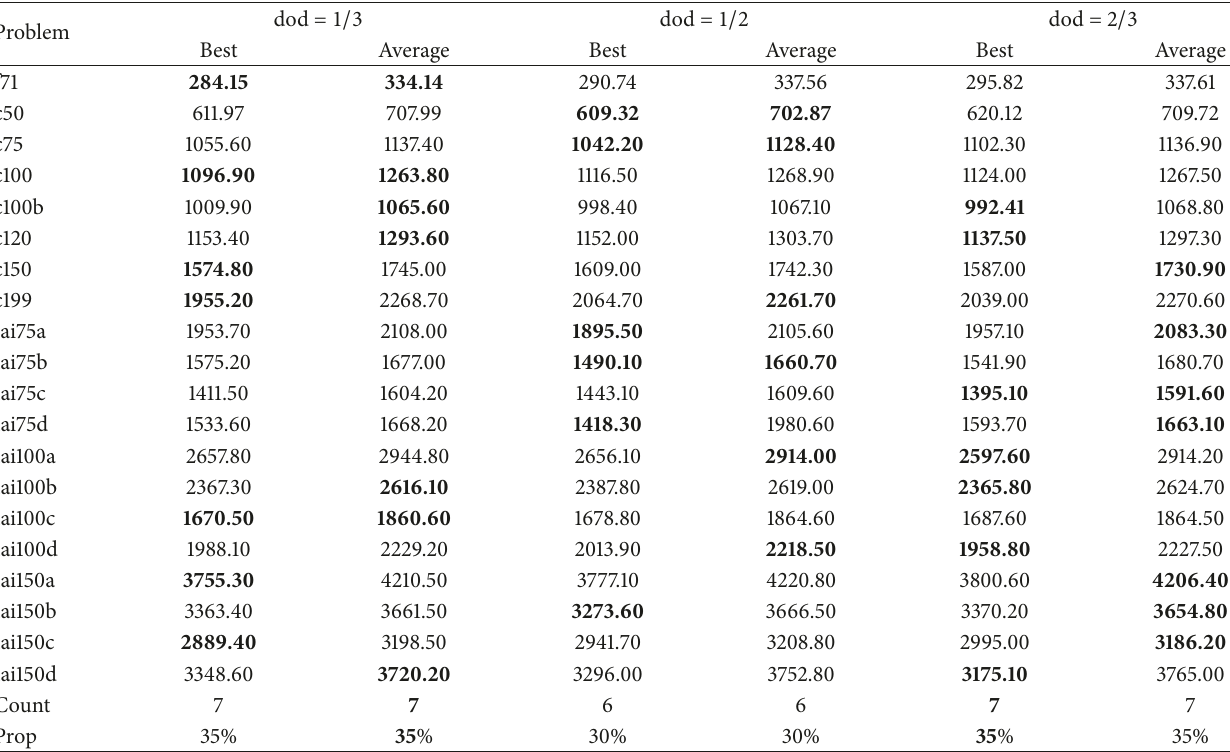
Table 7: Comparison of solutions based on different degrees of